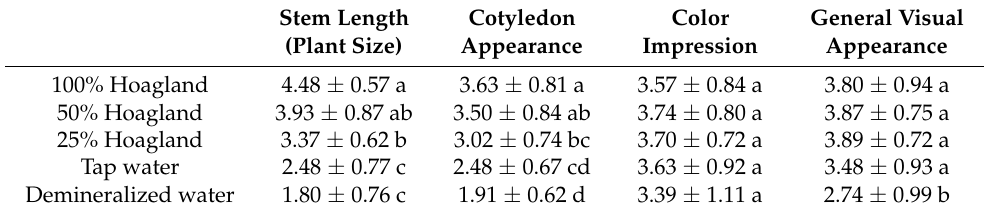
Table 14. Visual appearance of radish cress rated by untrained consumer tests. Different letters within a column indicate significant differences by Friedman tests.